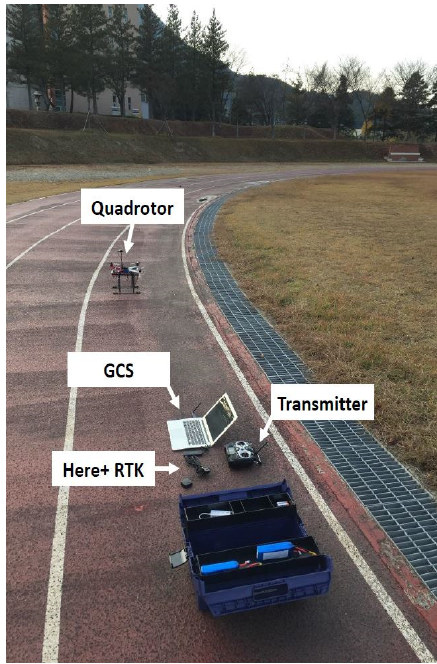
Figure 11. Flight experiment setup. Table 1. Waypoint file format.